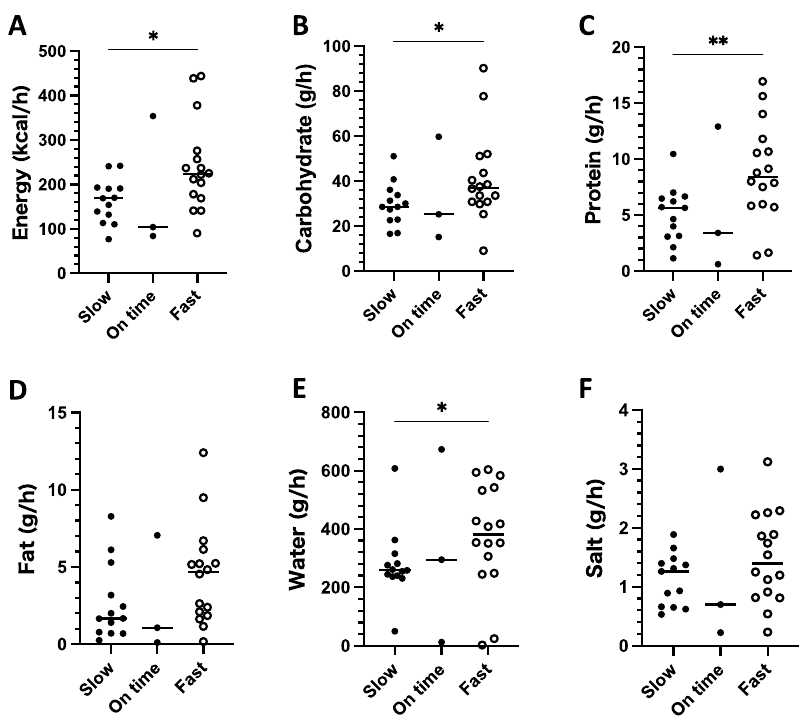
Figure 5. Comparison of energy ( A ), carbohydrate ( B ), protein ( C ), fat ( D ), water ( E ), and salt ( F ) intake among different running paces (fast, when the running pace was faster than planned; on time, when the running pace was the same as planned; slow, when the running pace was slower than planned). * p < 0.05 and ** p < 0.01 between fast and slow, Mann–Whitney test. The horizontal bar represents the median in each group.